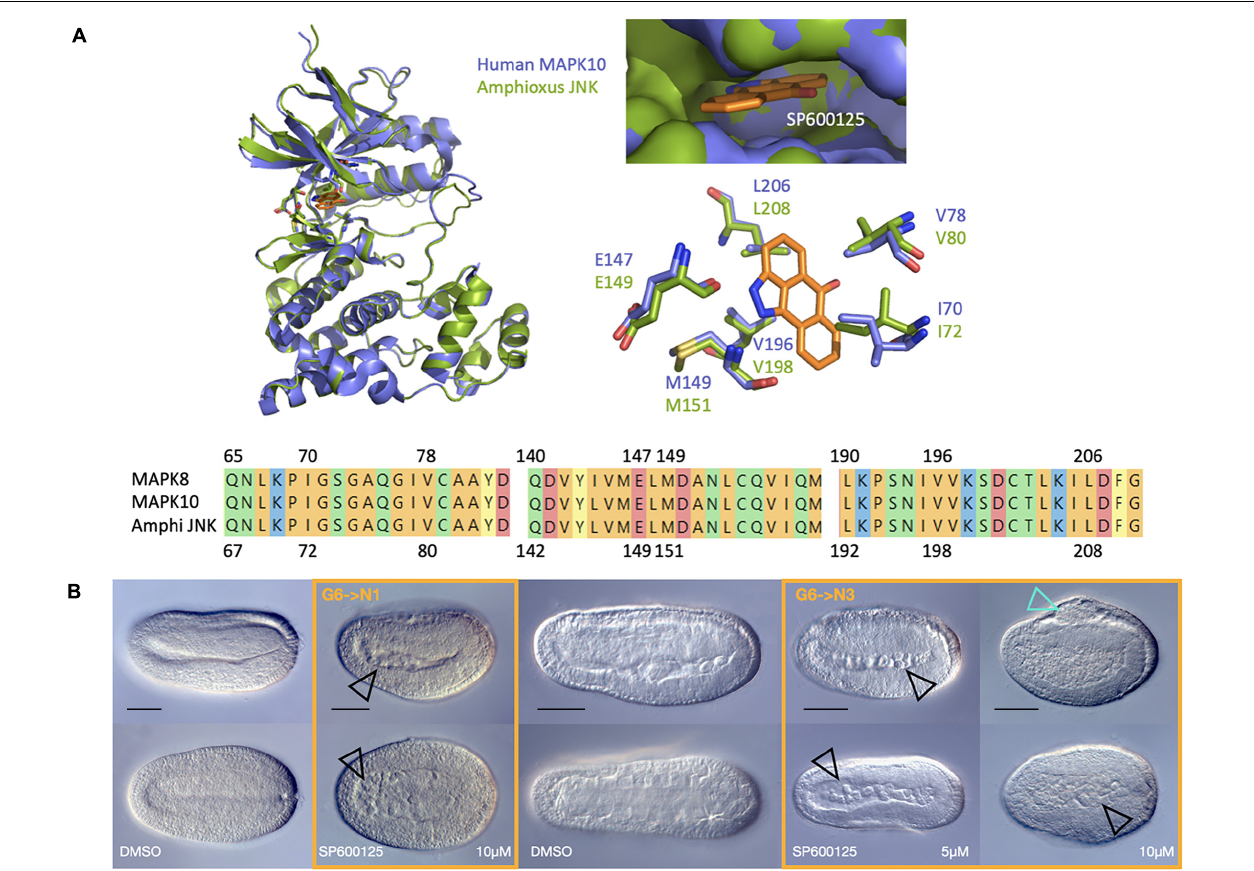
FIGURE 1 | SP6000125 is a specific JNK inhibitor in amphioxus and causes axis elongation defects. (A) Comparative modelling of the amphioxus JNK (green) in complex with the small molecule inhibitor SP600125 (orange) using human MAPK10 as a template (purple) reveals conservation of docking sites at conserved residues (top). The alignment of human MAPK8, human MAPK10, and amphioxus JNK shows 100% identity of residues within the actives site (bottom). (B) SP6000125 causes dose-dependent phenotypes when amphioxus embryos are treated at the late gastrula stage. The top row shows lateral views, with anterior to the left and dorsal up. The bottom row shows dorsal views. Treatments are boxed in orange, with their stage matched DMSO controls to the left. Black outlined arrowheads highlight an accumulation of cells within the gut after only short treatments with 10 µ M SP600125. Over time, all embryos exposed to the JNK inhibitor show elongation defects, and by N3, in addition to accumulation of cellular material within the archenteron (black arrowheads), treated embryos have fin-like dorsal protrusions (cyan outlined arrowhead) at 10 µ M SP600125. Representative embryos are shown. DMSO control, N1 n = 170; 10 µ M SP600125, N1 n = 126; 5 µ M SP600125, N3 n = 158. Scale bars = 50 µ